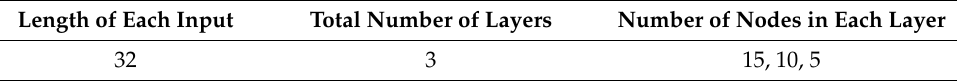
Table 2. Structure of the adopted deep neural network (DNN).